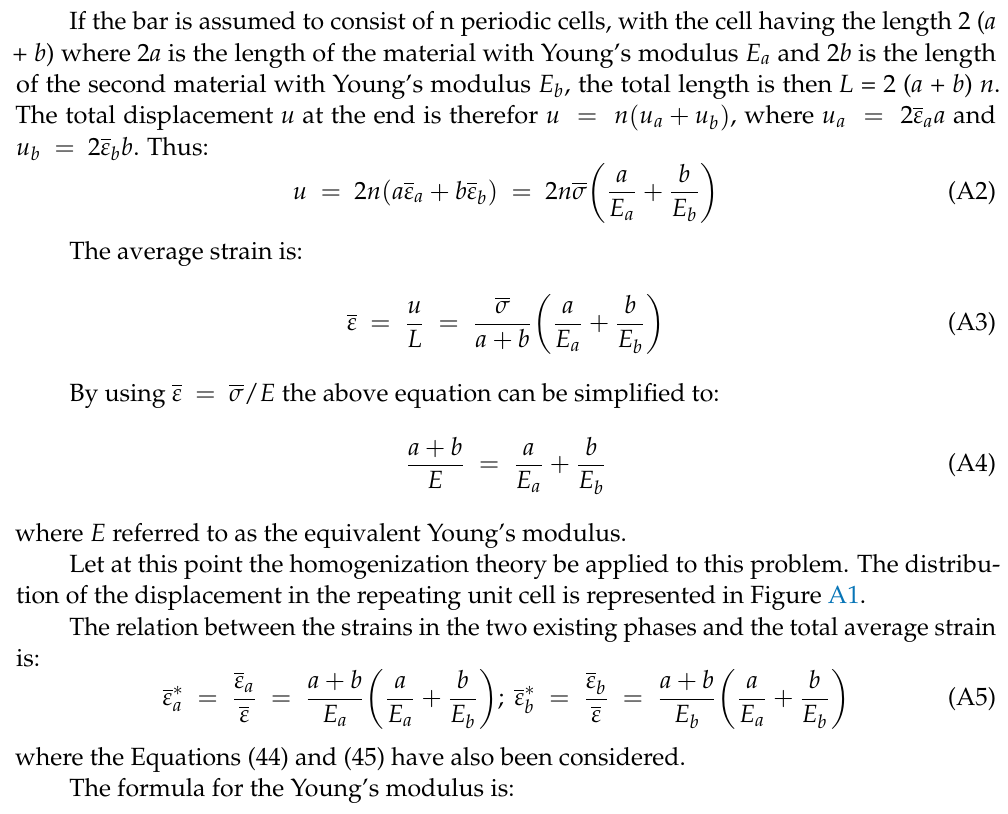
E as shown in Figure A1. The strain in b